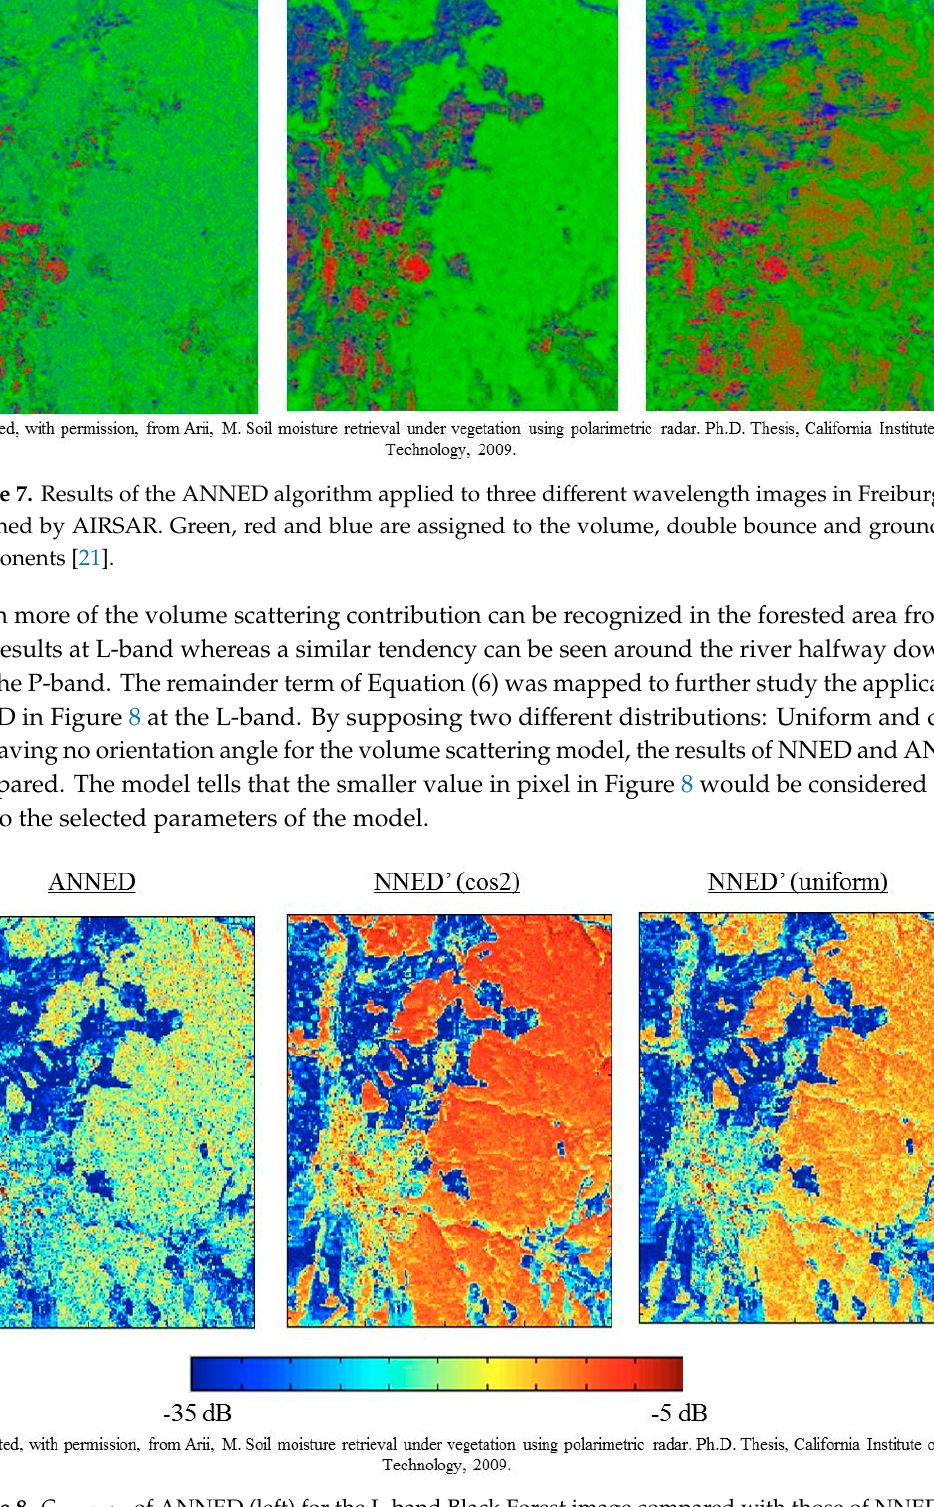
Figure 8. C remainder of ANNED (left) for the L-band Black Forest image compared with those of NNED’ (dash) using two distributions: cosine squared (center) and uniform (right) distribution. Note that the cosine squared distribution has a zero orientation angle [21]. Note that NNED’ is an extended version of NNED so that reflection symmetry [38] is never required.